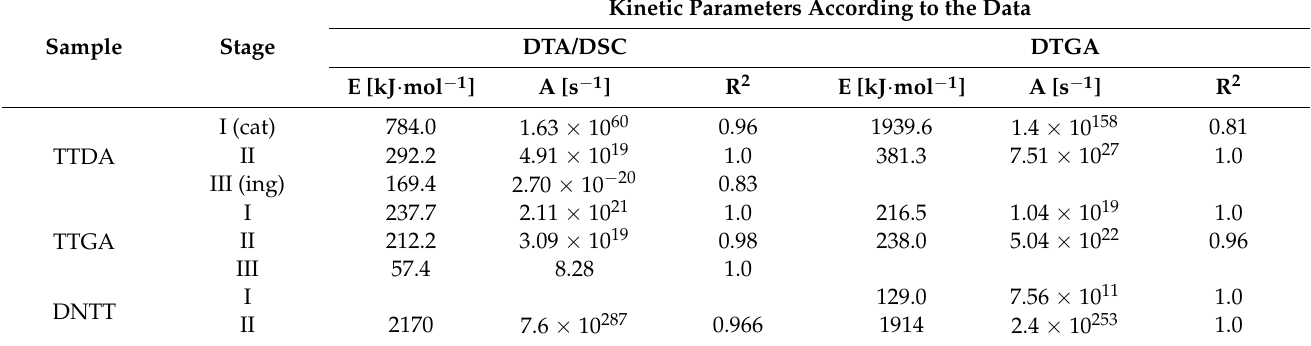
Table 8. Kinetic parameters of the limiting stage of thermal decomposition in the solid phase obtained by the Kissenger method.